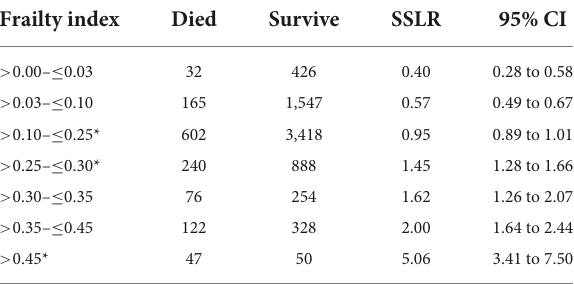
TABLE 2 Stratum-specific likelihood ratio (SSLR) for experiencing seven-year mortality in seven frailty-index strata using common proposed cut